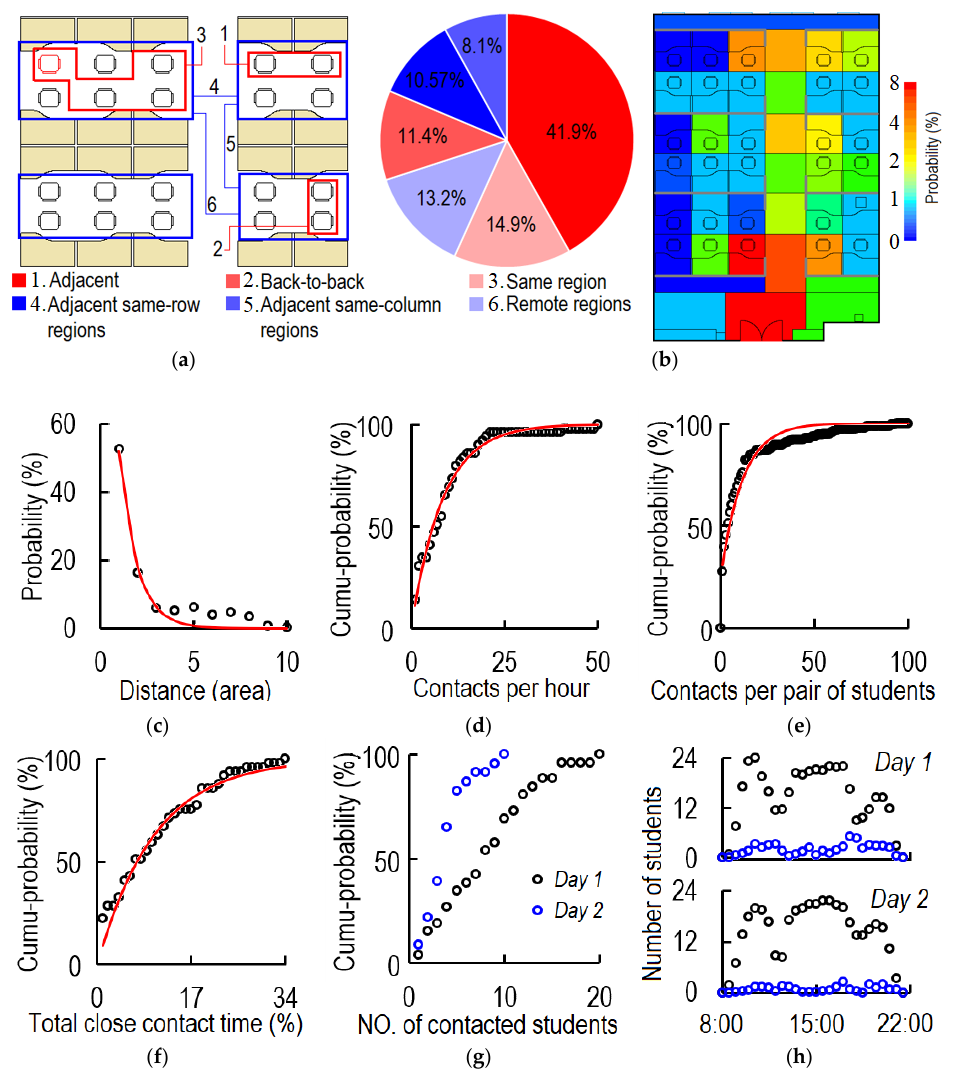
spent 34% of her indoor time in close contact. The average and median ratios of close contact time to total indoor time were 9.7% and 6.4%, respectively. During the two days, the students had close contacts with an average of 8.4 and 4.2 students, respectively. The most sociable student had close contacts with 10 and 20 students during day 1 and day 2 , respectively (Figure 7g).